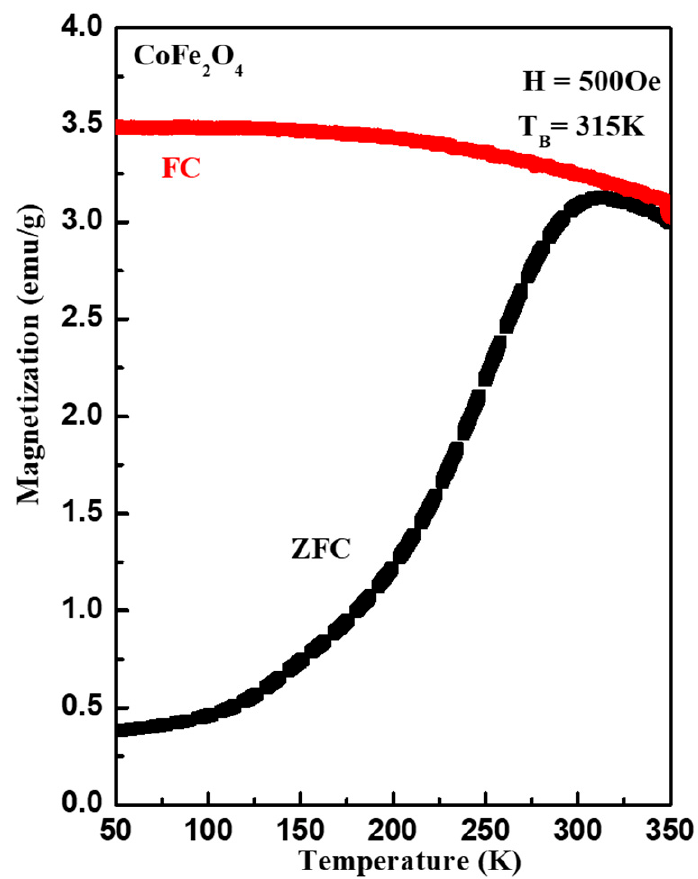
Figure 3. Field-cooled (FC) and zero-field-cooled (ZFC) magnetization versus temperature curves of CeFe 2 O 4 nanostructures measured in a magnetic field of 500 Oe.